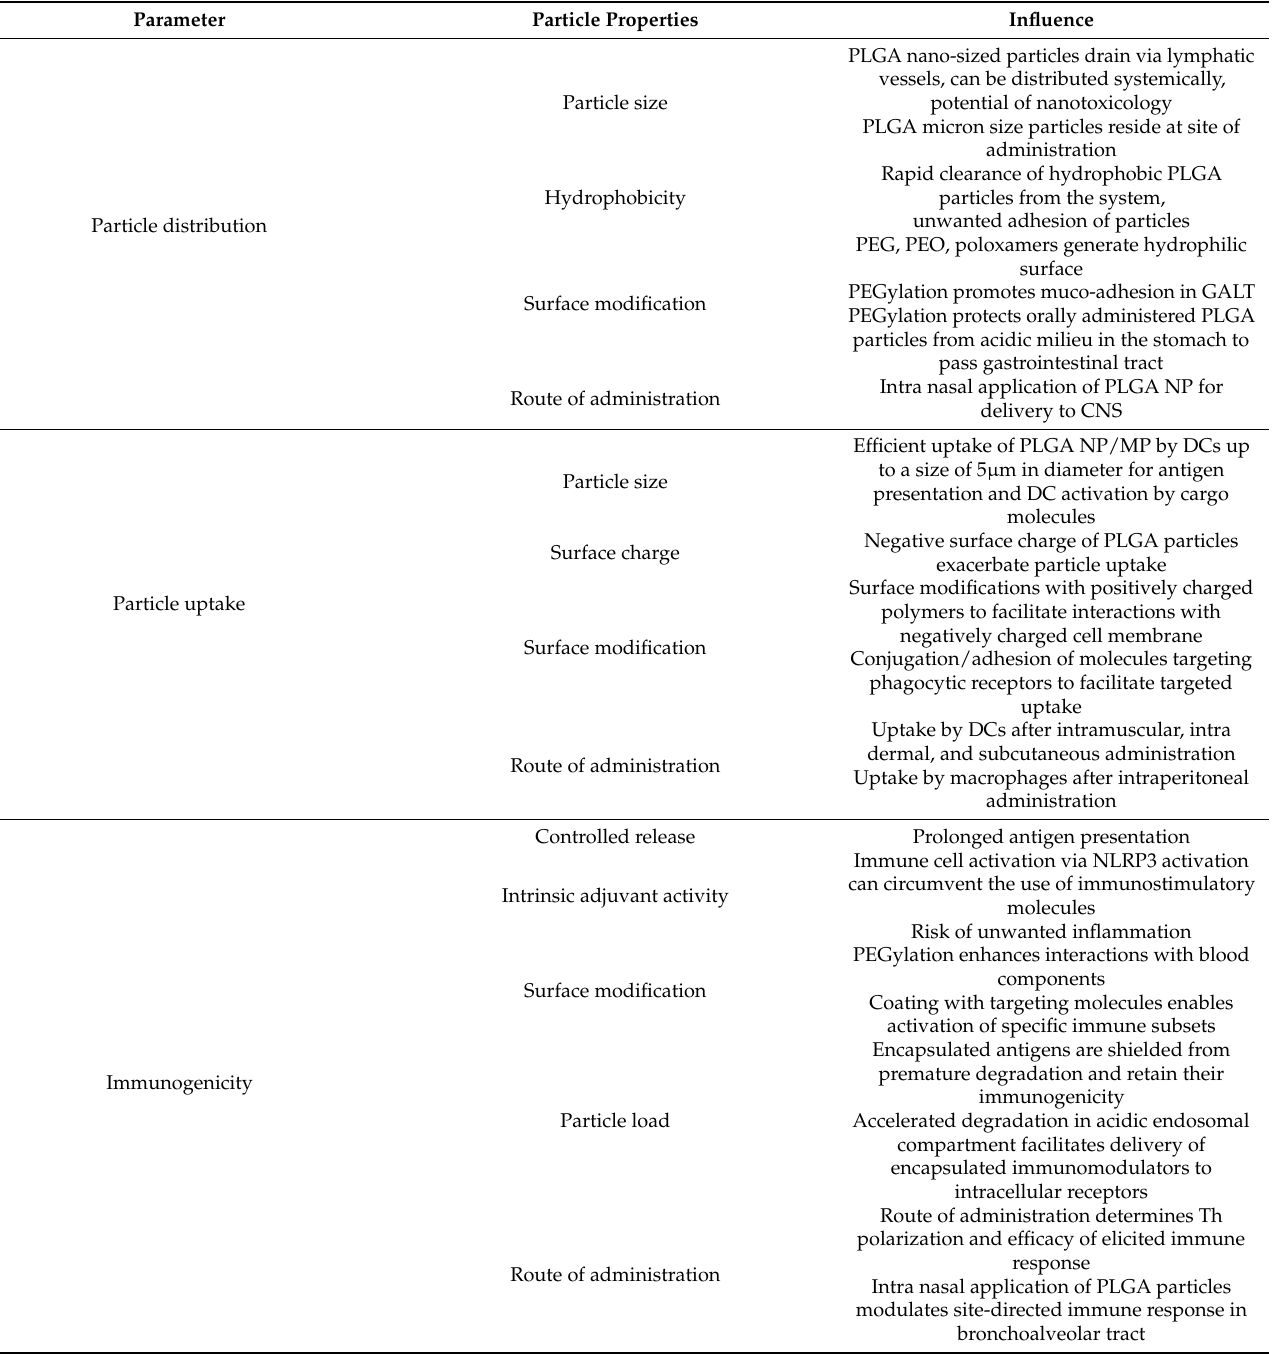
Table 1. Influences of PLGA particle properties on parameters relevant for